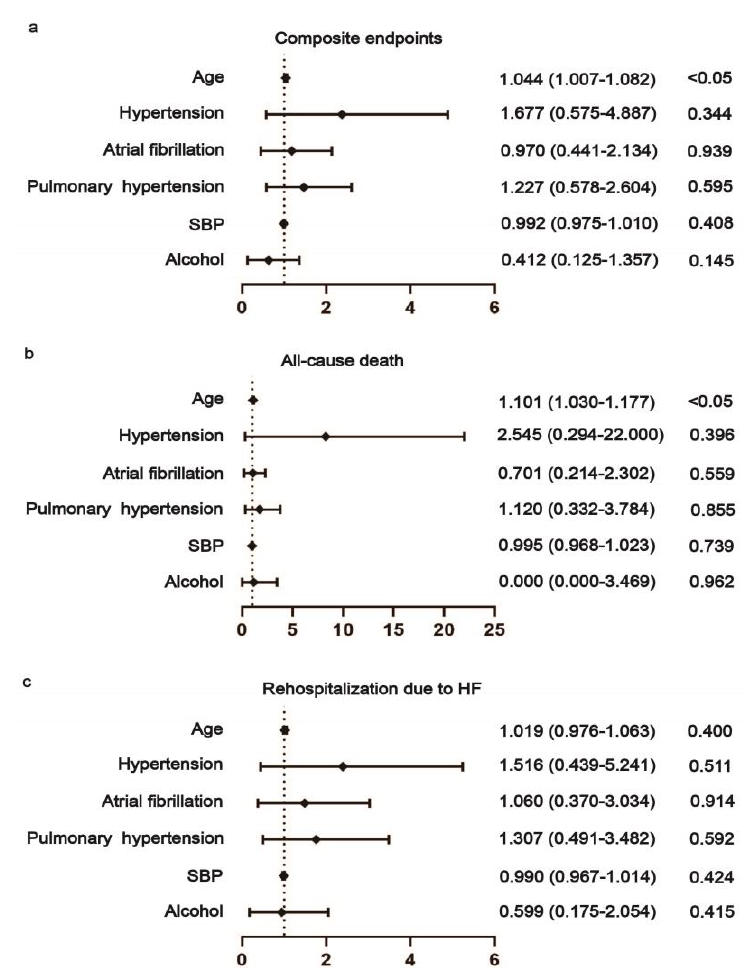
Figure 6. Association between risk factors and prognosis in DCM-HFpEF patients. Age was a positive predictor for both a composite endpoint ( a ) and death ( b ) of DCM-HFpEF patients. SBP: systolic blood pressure. ( c ) No association was found between these risk factors and prognosis in DCM-HFpEF patients.